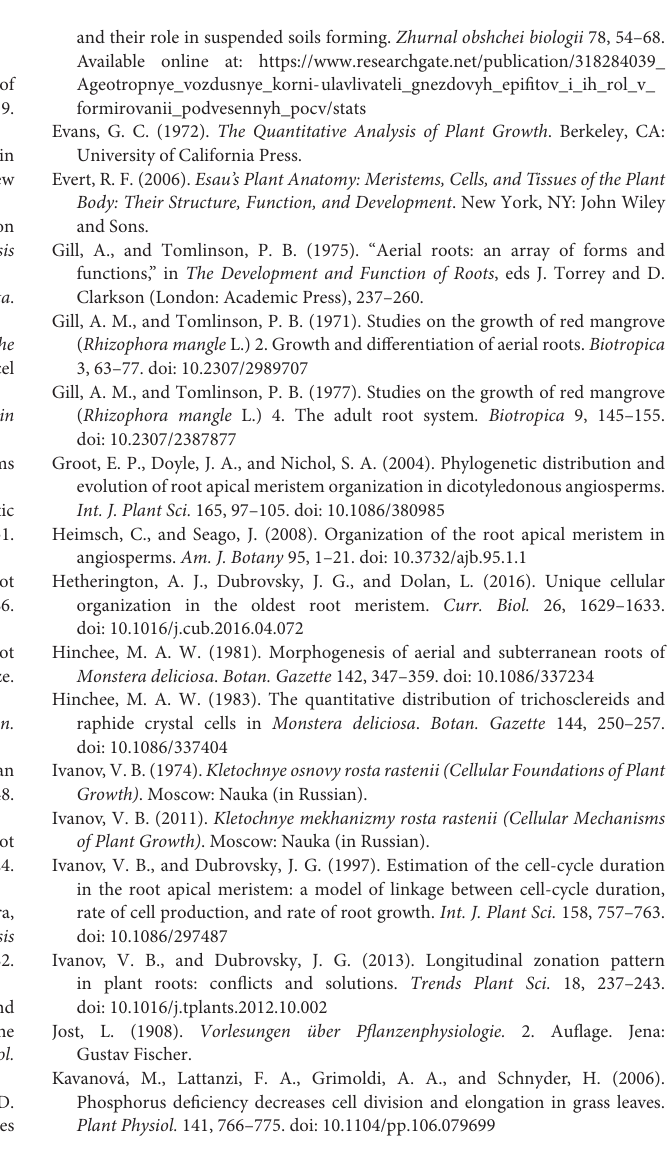
Supplementary Table S1 | Primary data of growth rate determinations of aerial roots of 20